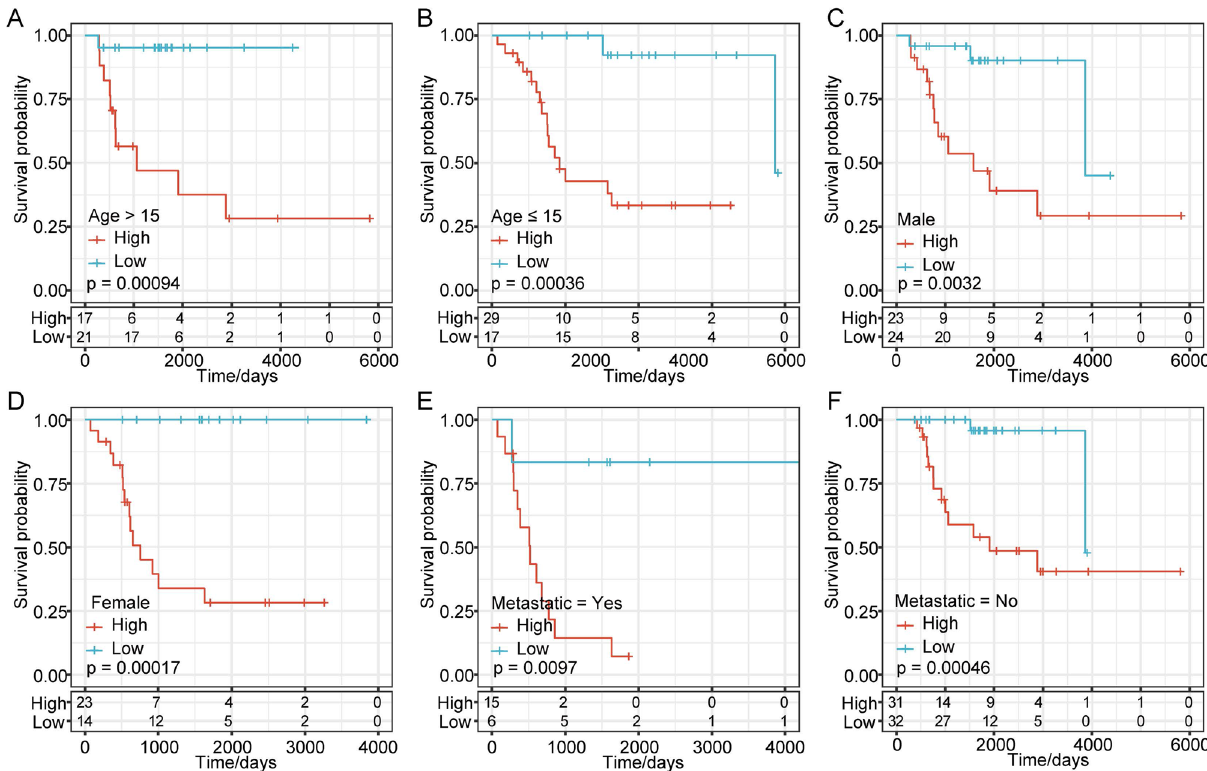
Figure 6. Kaplan–Meier curves for clinical characteristics. ( A ) Kaplan–Meier curve based on age > 15 years. ( B ) Kaplan–Meier curve based on age ≤ 15 years. ( C ) Kaplan–Meier curve of the male group. ( D ) Kaplan–Meier curves of the female group. ( E ) Kaplan–Meier curve of the group with metastasis. ( F ) Kaplan–Meier curve of the group without